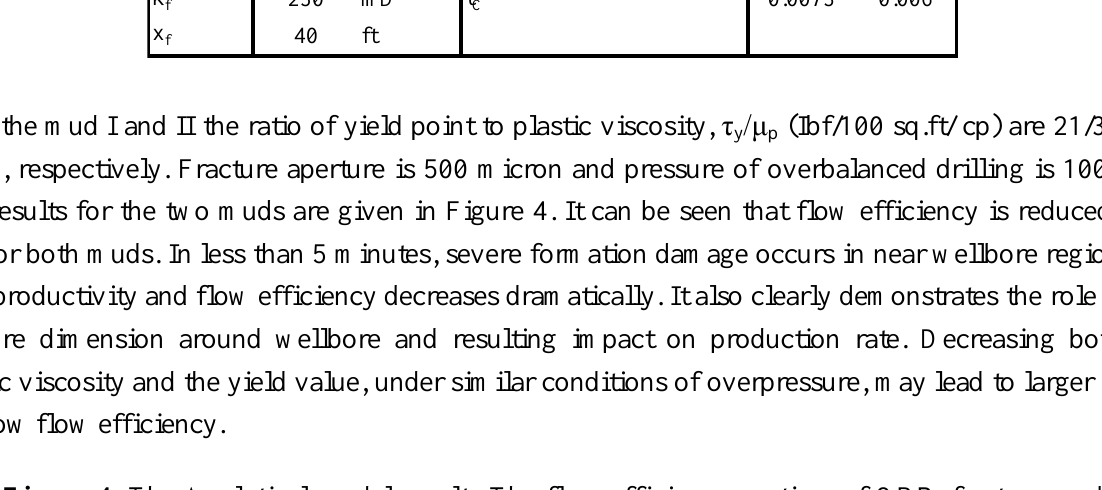
Figure 4. The Analytical model results-The flow efficiency vs. time of OBP, for two mud